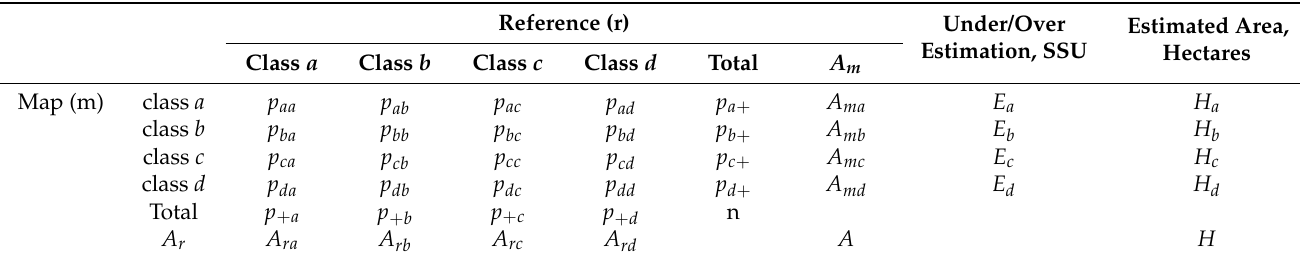
Table 2. Population of data ( n ) and the map proportion area ( p ) confusion matrix with map as rows (m) and reference as columns